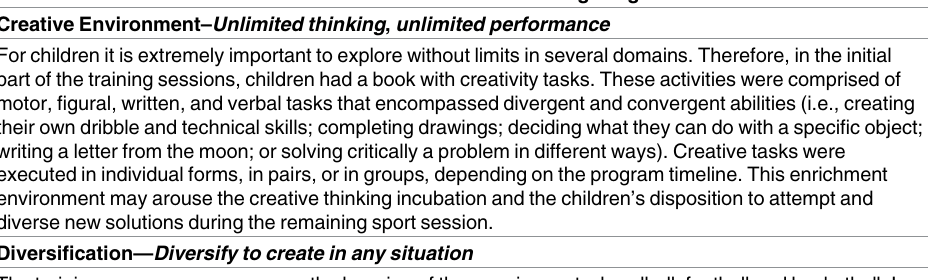
Table 1. Description of the general Skills4genius training program tenets. Tenets of the Skills4Genius Training